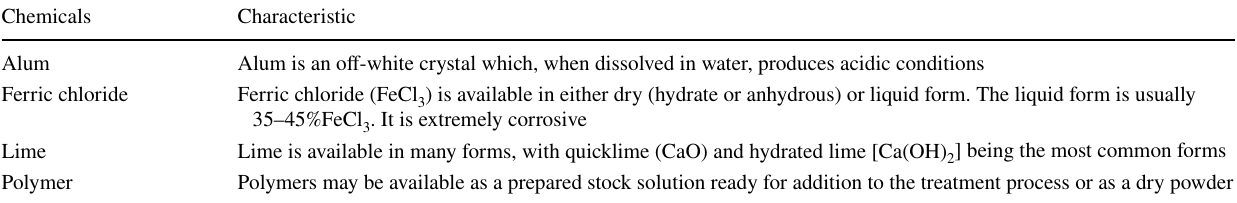
Table 2 Common precipitants and their characteristics (USEPA 2000) Chemicals